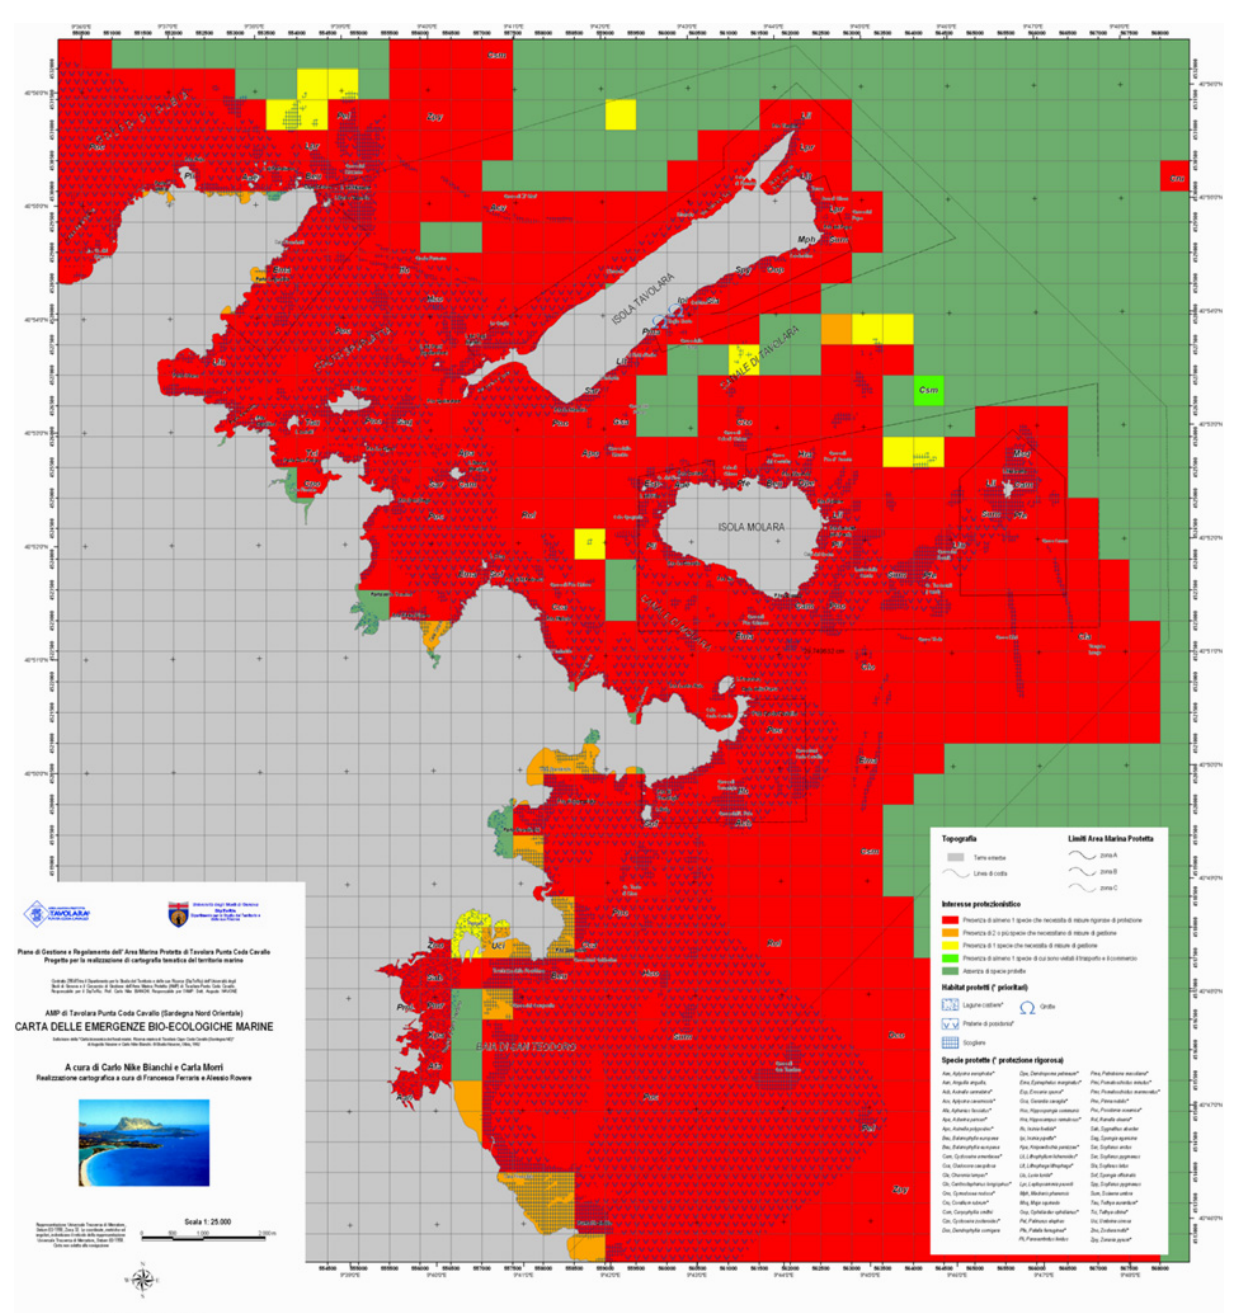
Figure 4. Reproduction at reduced scale of a map of marine natural emergencies. The example illustrates the MPA “Tavolara-Punta Coda Cavallo” (original scale 1:25,000). This and similar maps can be freely downloaded, at their full size, from the SEAMap site